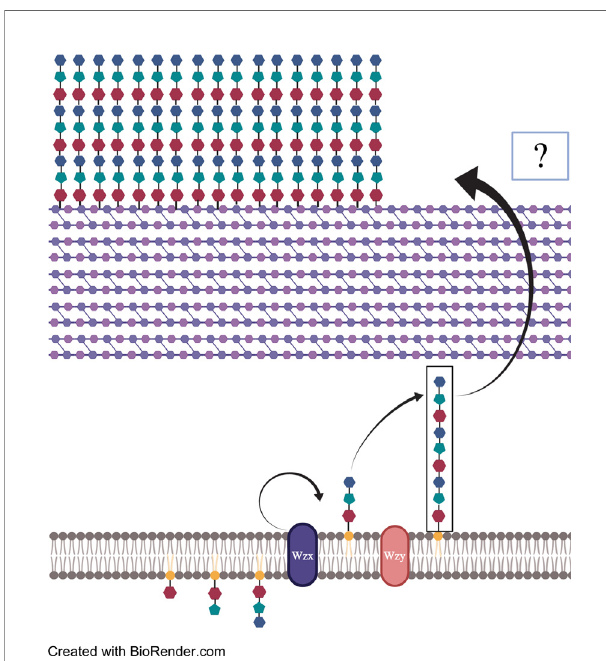
FIGURE 2 | A pictorial explanation ofWzy-mediated CPS synthesis. Repeated patterns of monosaccharides are transported to andadded to undecaprenylphosphate (Und-p). The polysaccharidestrip isthen fl ipped across the membrane by Wzx fl ippase andrepeat segments are added onto the non-reducing end byWzy polymerase. Oncethe desired length isreached, polysaccharidechains are exportedfrom the cellmembrane to the peptidoglycan byunknown means, where they bindcovalently via glycosidicbond.